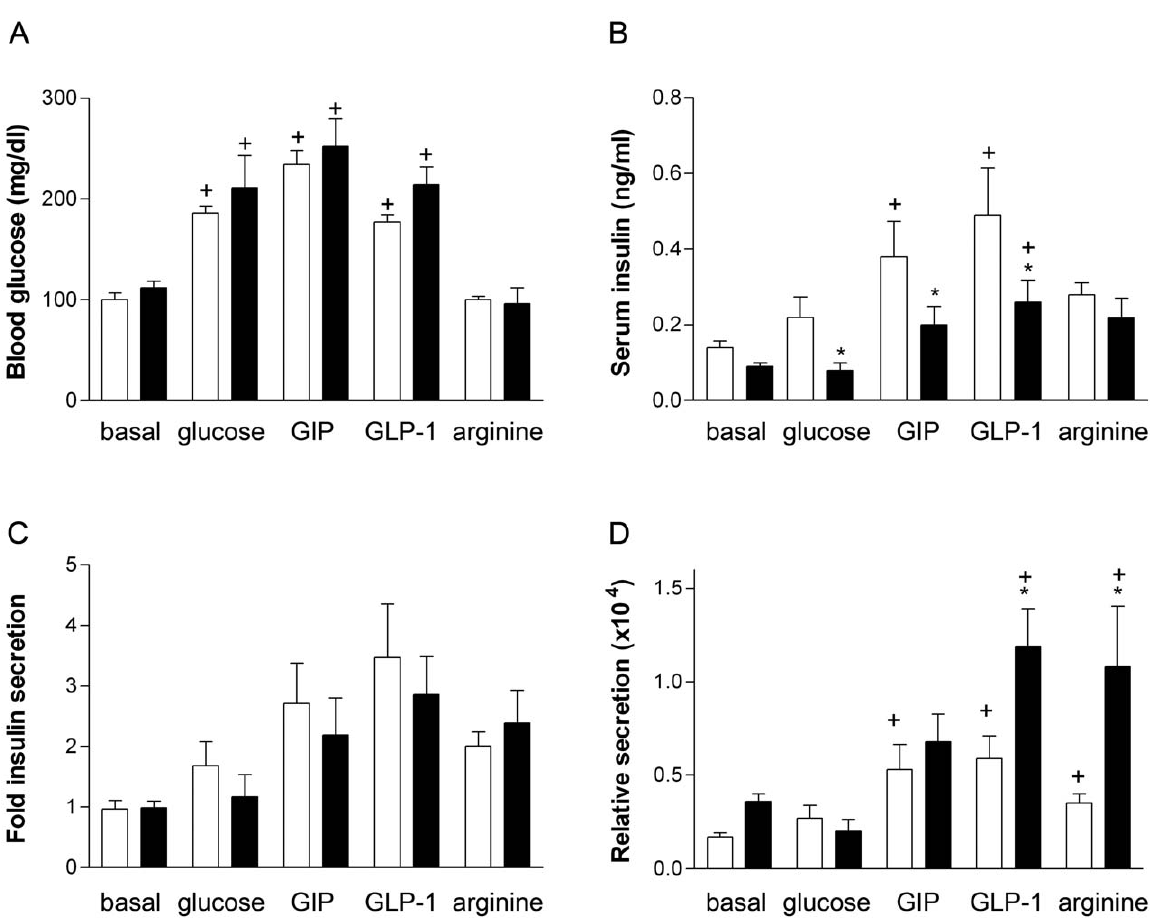
Figure 5. In vivo insulin secretion studies at 10 days of age. (A) Blood glucose, (B) serum insulin levels, (C) increase of serum insulin levels from basal levels (fold insulin secretion), (D) serum insulin to pancreatic insulin ratio; Open bars: control mice; filled bars: GIPR dn transgenic mice; Data represent means and SEM. * p , 0.05 vs. age-matched control; + p , 0.05 vs. basal values.